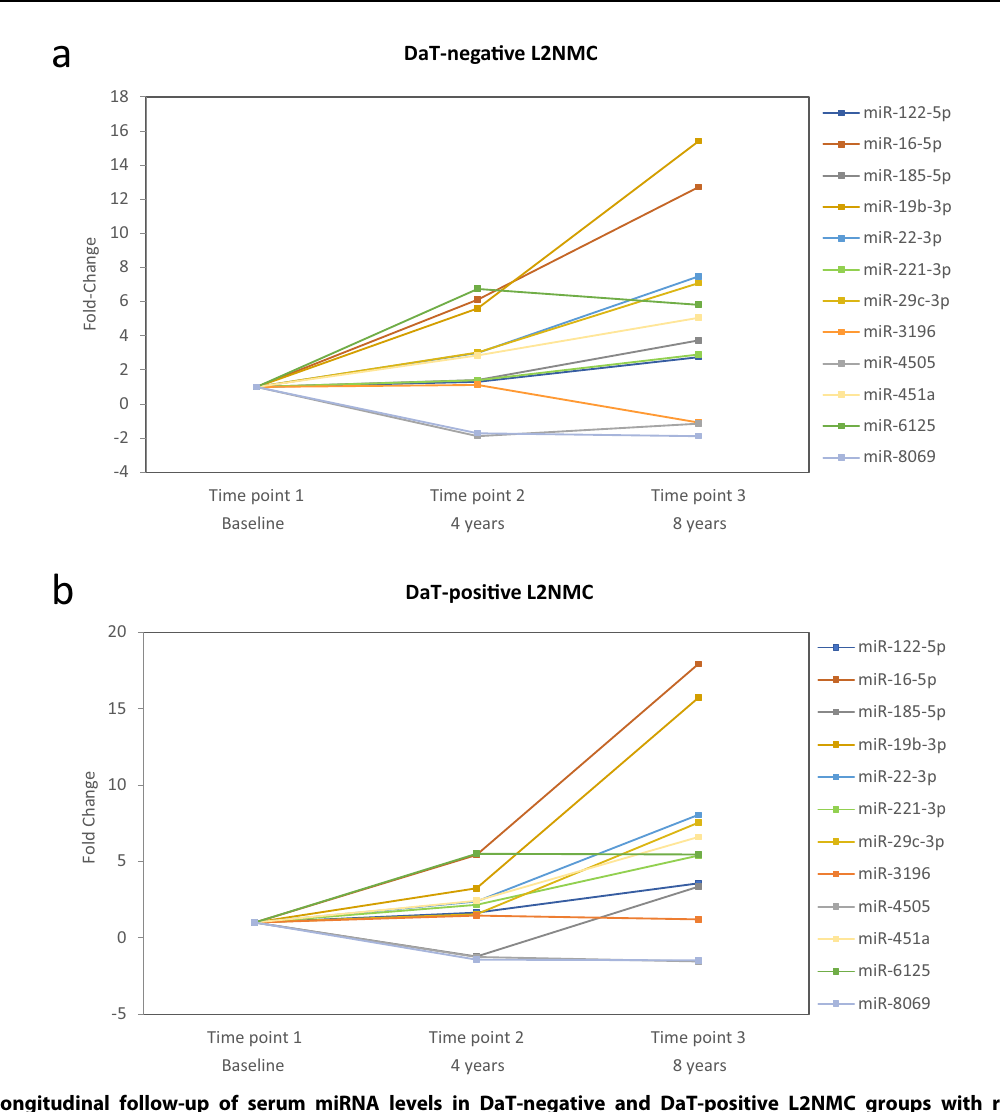
Fig. 6 8-year longitudinal follow-up of serum miRNA levels in DaT-negative and DaT-positive L2NMC groups with respect to their corresponding baselines. Longitudinal fold-change values in a DaT-negative L2NMC and b DaT-positive L2NMC. DaT DaT-SPECT imaging, L2NMC LRRK2 non-manifesting